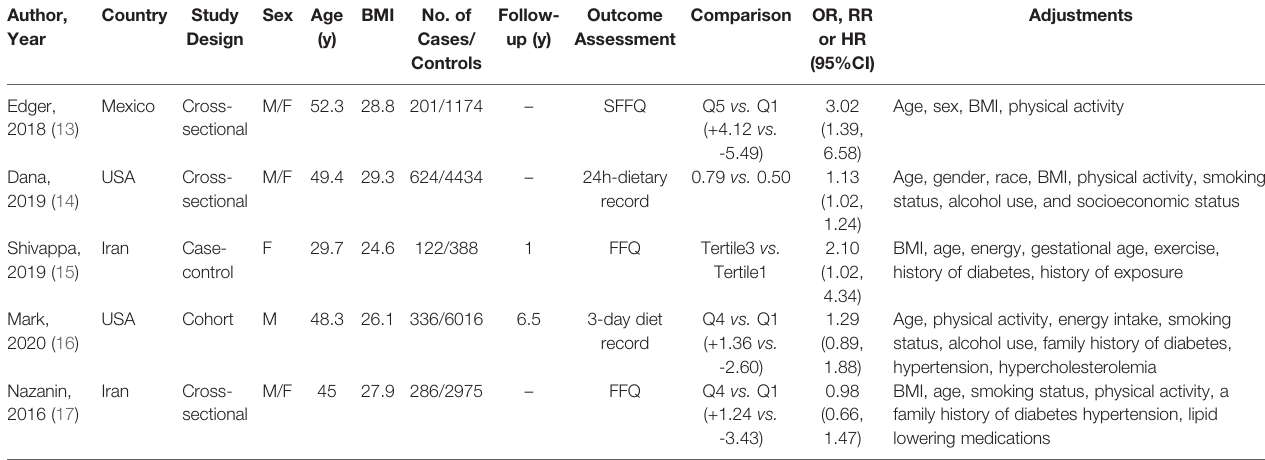
TABLE 1 | Main characteristics of the studies included in the systematic